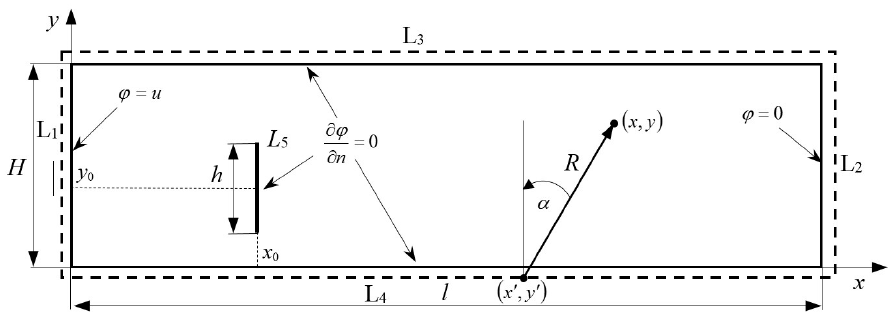
Figure 6. Analyzed model of conductive path with defect.